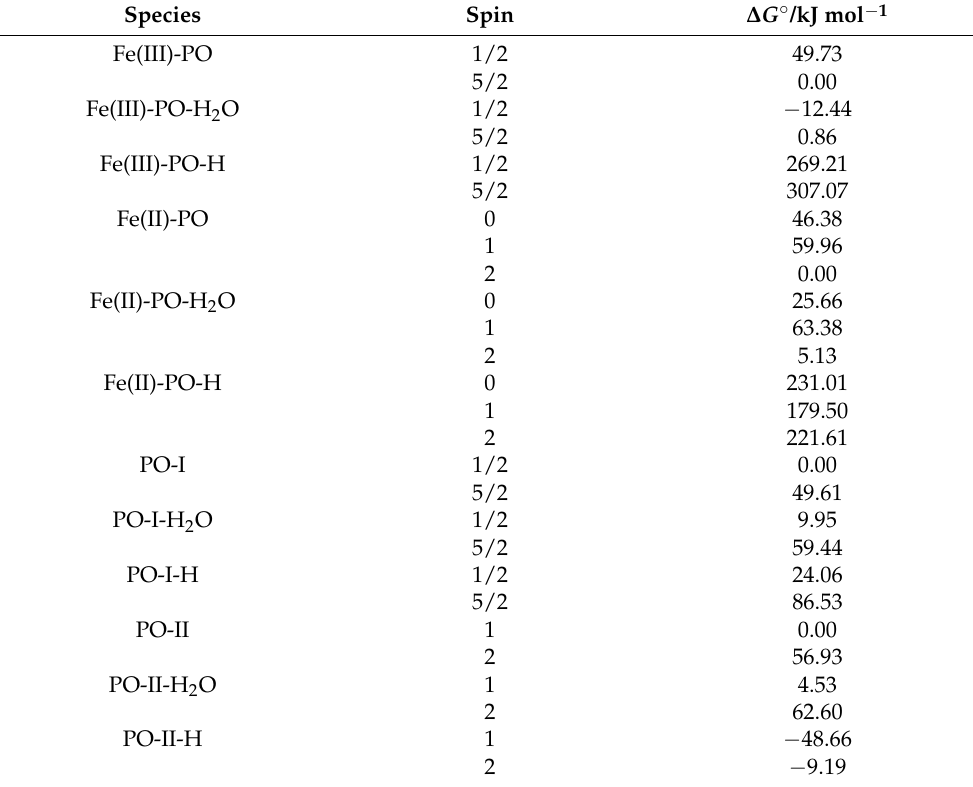
Table 1. Gibbs free energy obtained with B3LYP/cc-pVDZ ( T = 298.15 K) for all the studied species optimised at low, intermediate (for ferrous complexes only) and high spin. The most stable species of each non-protonated compound was used as benchmark. The relative values of protonated and aquo complexes were calculated with respect to the independent corresponding non-protonated species plus H + or H 2 O, as